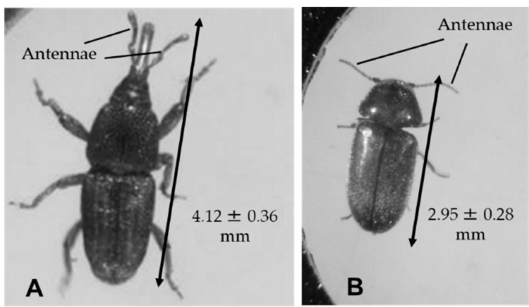
Figure 1. Body length of rice weevil ( A ) and cigarette beetle ( B ). The body length was measured using twenty adults of each insect